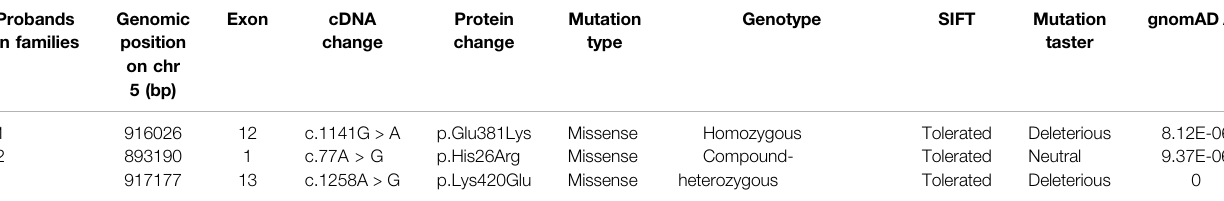
TABLE 2 | Overview of the TRIP13 variants observed in two families. Probands in